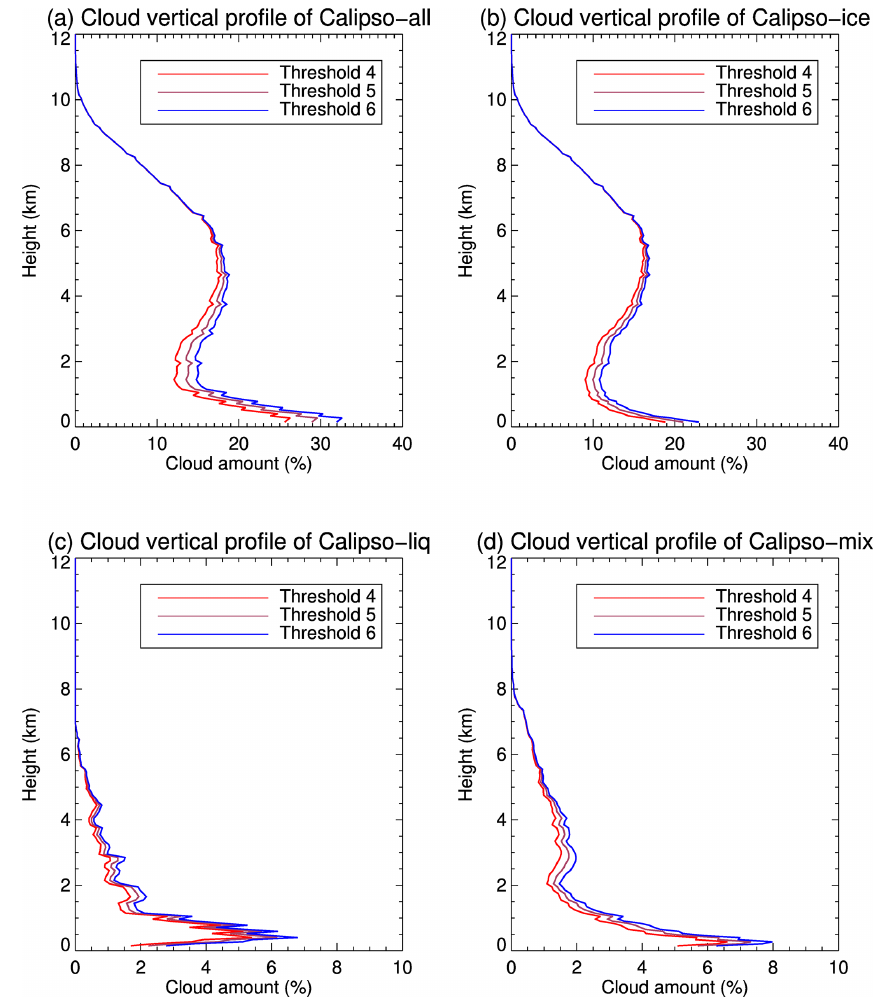
Figure 18. CALIPSO cloud amount vertical profile with three optical thickness thresholds of 4, 5, and 6 for (a) all, (b) ice, (c) liquid, and (d) mixed-phase